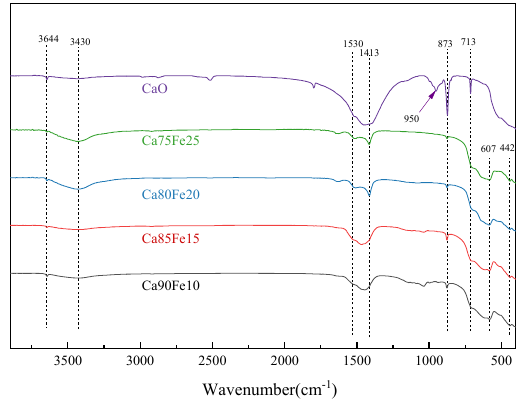
Figure 6. FT–IR spectrum of catalysts.